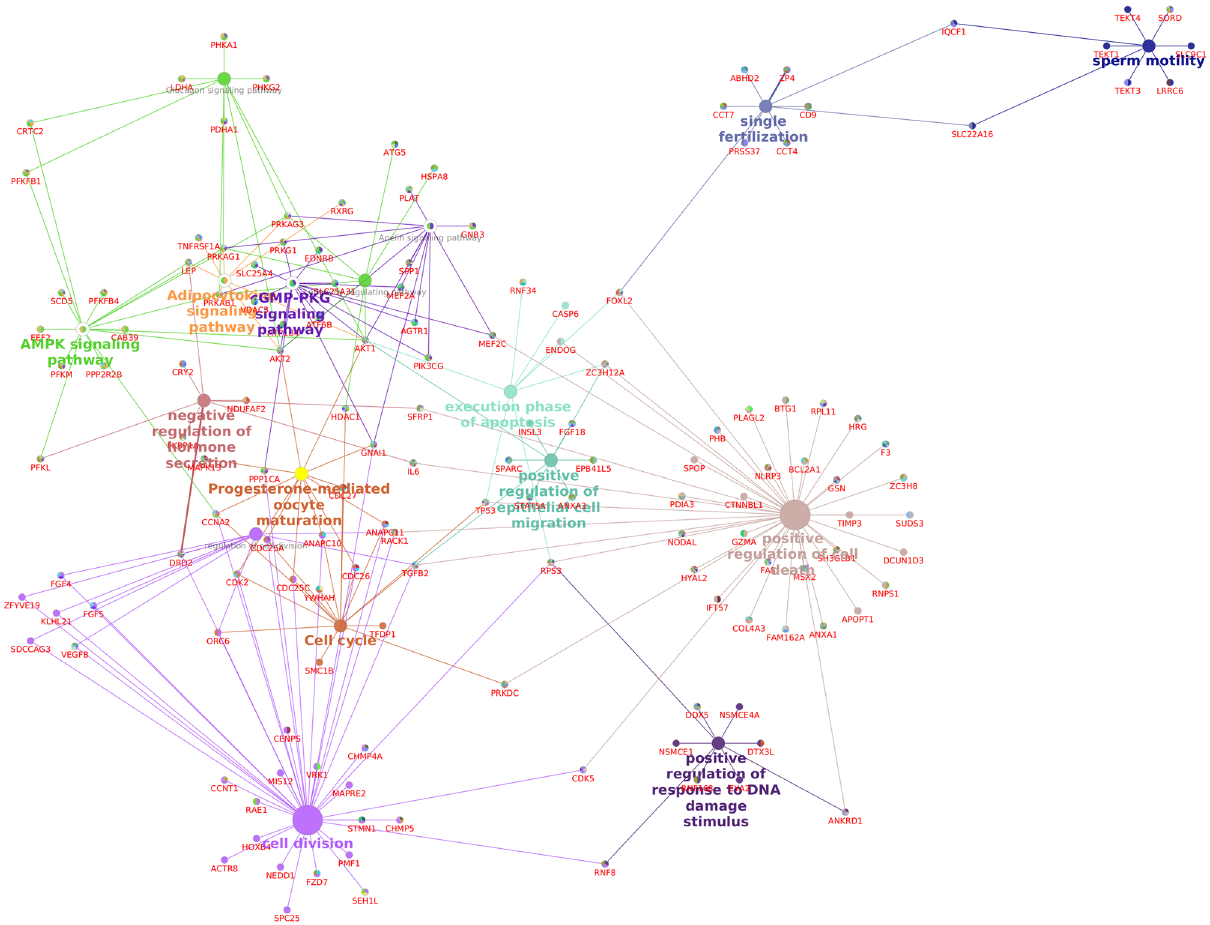
Figure 4. Interaction network of dysregulated transcripts and